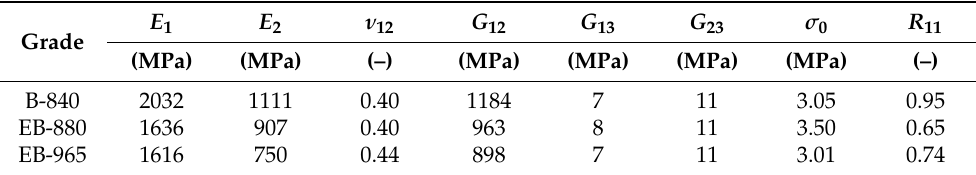
Table 2. Corrugated board data used in the constitutive models.